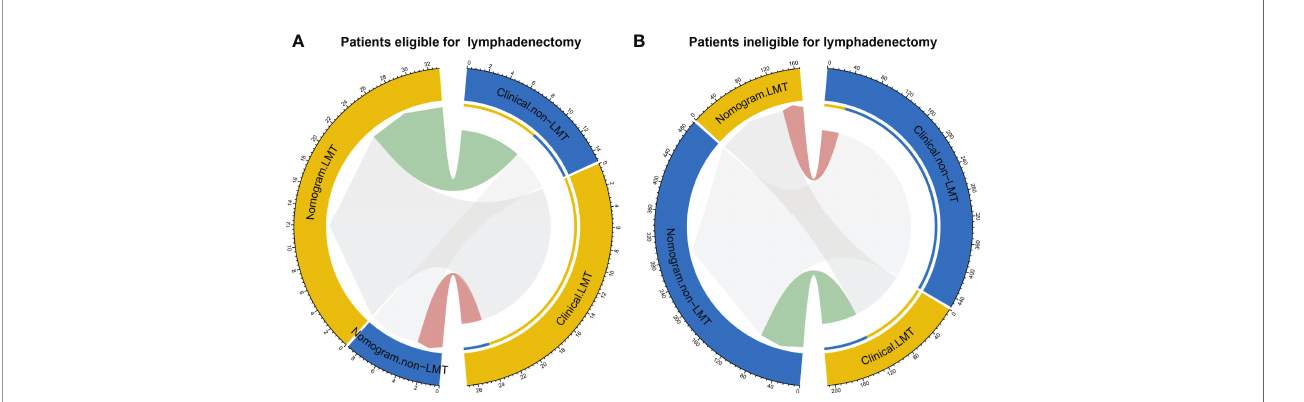
FIGURE 5 | Reclassi fi cation of patients for eligible for lymphadenectomy (A) and in eligible for lymphadenectomy (LMT) (B) . Groups are illustrated according to the radiomics nomogram and clinical model-determined lymphadenectomy eligibility basing on the entire dataset with the speci fi c patient numbers are presented. The patients were pathological con fi rmed whether eligible for lymphadenectomy. In the circle plots, the patients who were classi fi ed both correctly by clinical and nomogram are represented as connections in light grey. The connections in light green indicate patients who were clinically diagnosed incorrectly but reclassi fi ed correctly by the nomogram, while connections in pink indicate patients who were clinically diagnosed correctly but reclassi fi ed incorrectly by the